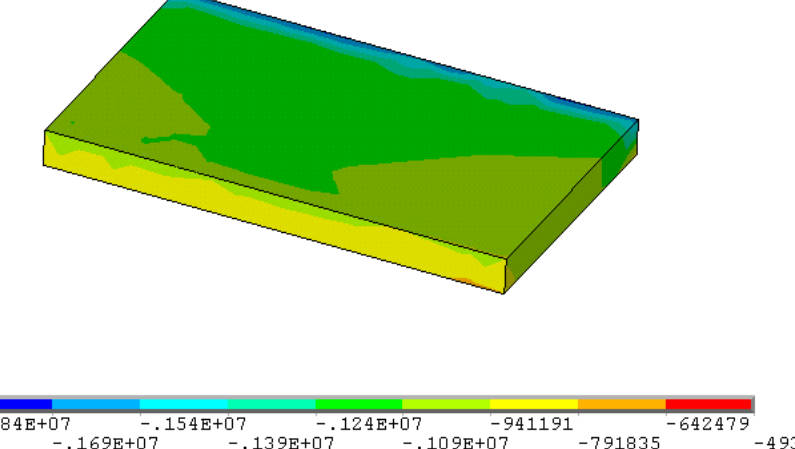
Table 2. Numerical simulation results of the recovery process before optimization.